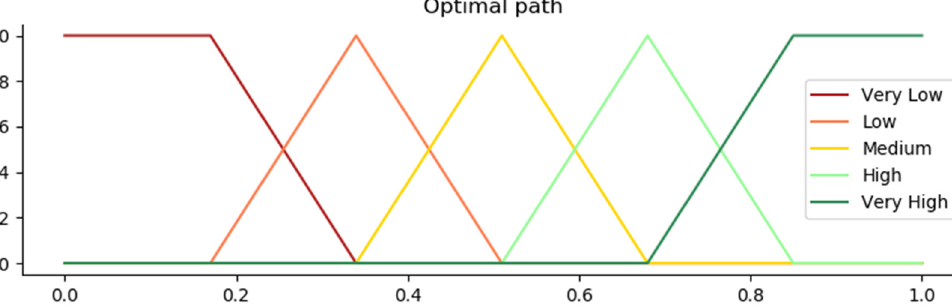
Figure 5. Membership function of Criterion 3 (Equation (3)) of energy consumption.